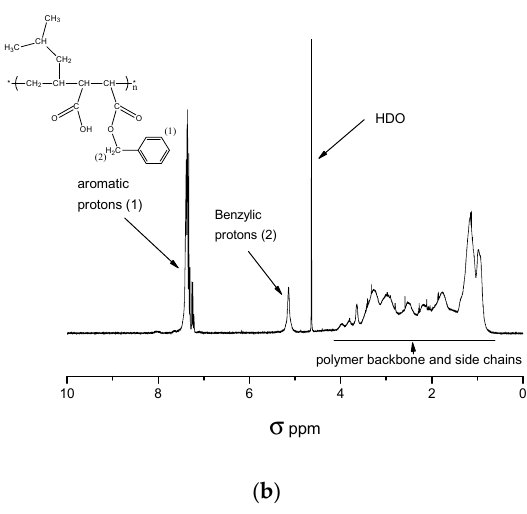
Figure 1. ( a ) 1 H-NMR spectrum of P[MP-alt-MSA] measured in acetone d 6 ; ( b ) 1 H-NMR spectrum of P[MP-alt-MSA] esterified with benzyl alcohol measured in D 2 O.